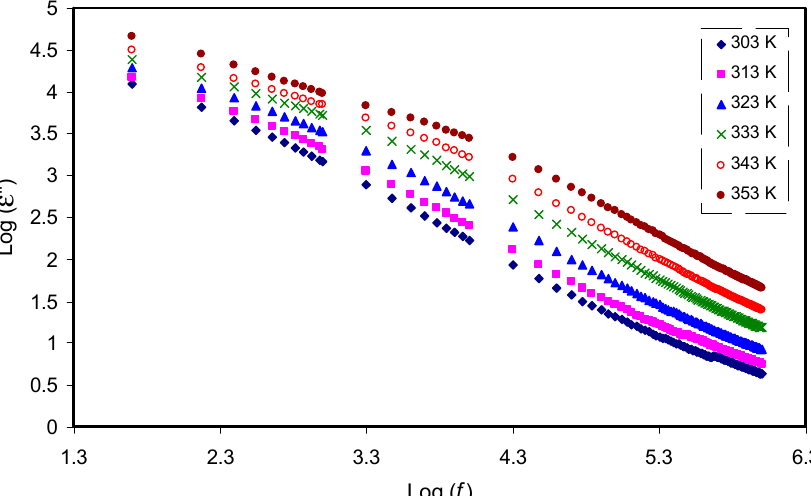
Figure 6. Frequency dependence of dielectric loss ( ε (cid:48)(cid:48) ) at selected temperatures for the CS: POZ: MgTf system. The dispersion in dielectric loss spectra rises with rising